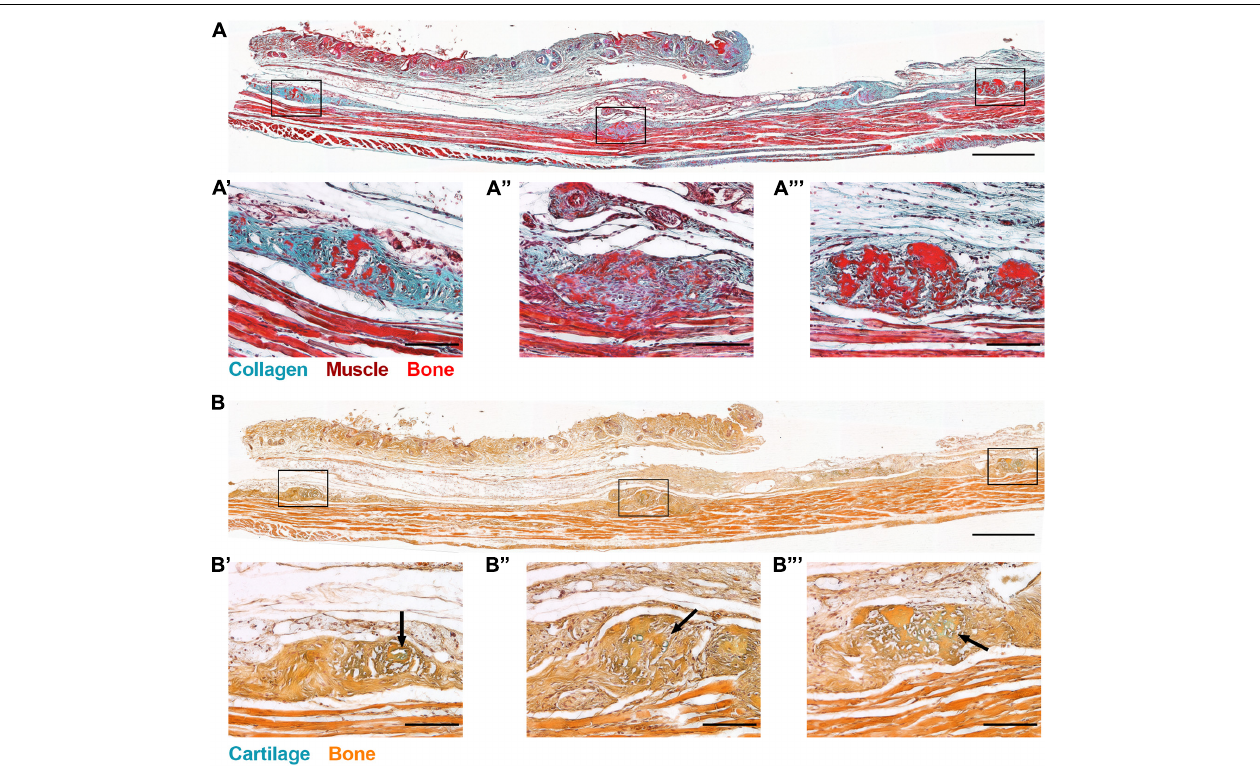
FIGURE 2 | Global Gnas inactivation induces subcutaneous heterotopic ossification. R26-CreERT2;Gnas fl / fl ;Ai9 fl / + mice (at 4 weeks old) injected intraperitoneally with tamoxifen were examined for ectopic bone formation. At 8 weeks post-induction, skin tissue sections from Gnas -null mice were stained with (A) Goldner’s trichrome (blue-green, Collagen; brown, Nuclei; red, Muscle; and bright red, Bone), and (B) Alcian Blue (cartilage) and Orange G (bone); scale bar = 500 µ m. Higher magnification images of HO deposits throughout the skin section highlight excess collagen (A (cid:48) –A (cid:48)(cid:48)(cid:48) ) and matrix proteins commonly associated with chondrogenesis within HO regions ( B (cid:48) –B (cid:48)(cid:48)(cid:48) , arrows); scale bar = 100 µ m; n =